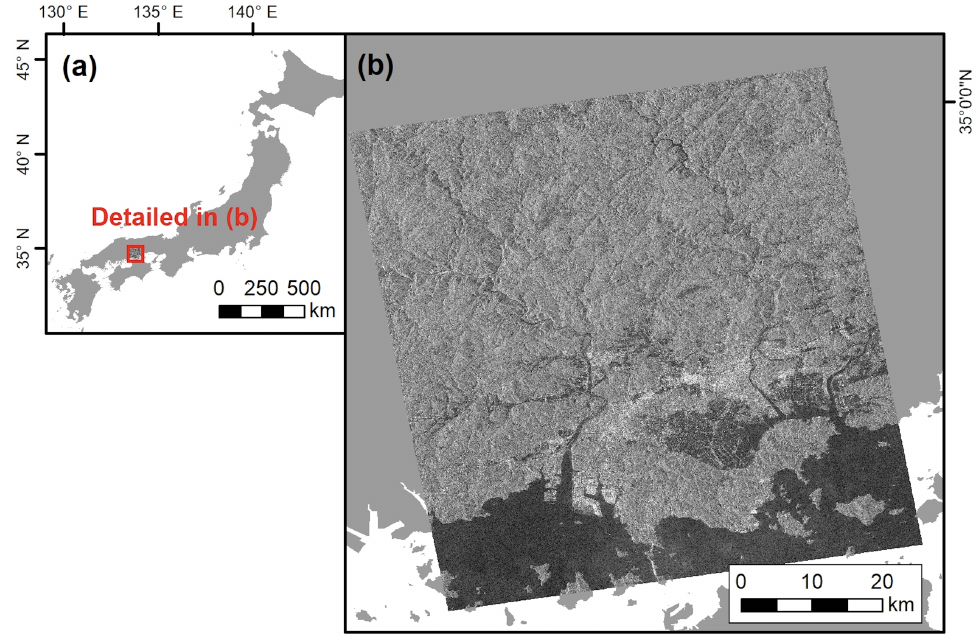
Figure 1. Study area: ( a ) map of Japan, showing detail area; ( b ) ALOS-2/PALSAR-2 data capturing the study area.